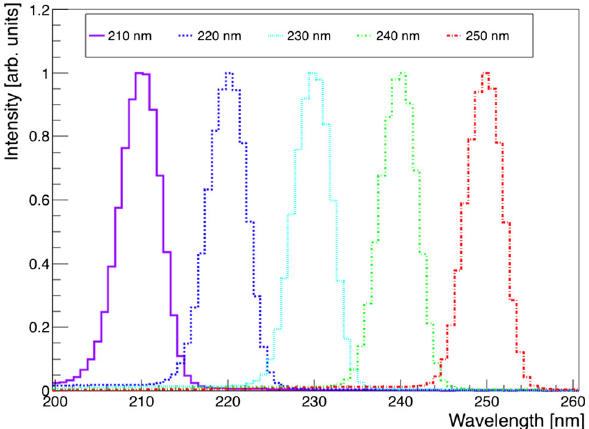
Fig. 3 A set of light specta measured downstream of the monochro- mator’s exit slit for several wavelength settings using an Al + MgF 2 diffraction grating. Each label indicates what the monochromator was set to when each spectrum was taken. There is good agreement between the monochromator setting and the output spectrum. All spectra peaks are normalized to one